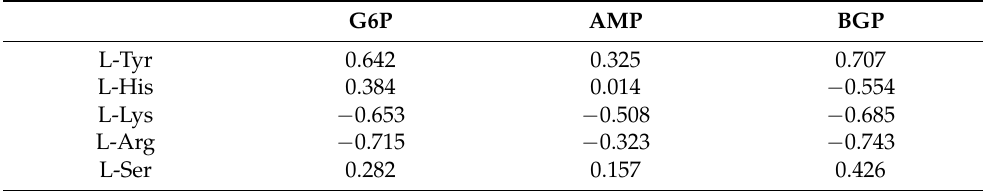
Table 2. Pearson correlation coefficient of the concentrations of amino acids and the inhibition